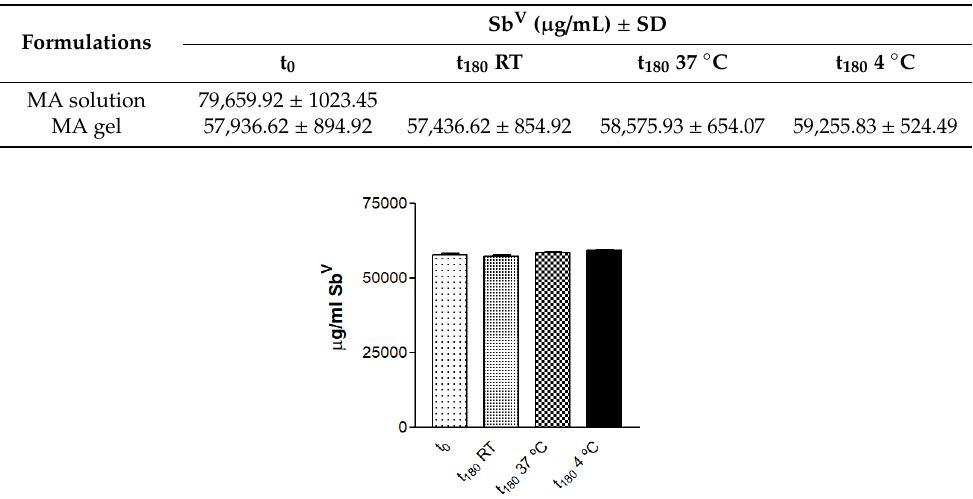
Table 1. Concentration of Sb V and SD in the reference solution and MA gel samples at the beginning of the experiment and 6 months later at di ff erent storage temperatures (t 0 = initial time; t 180 = after 6 months).